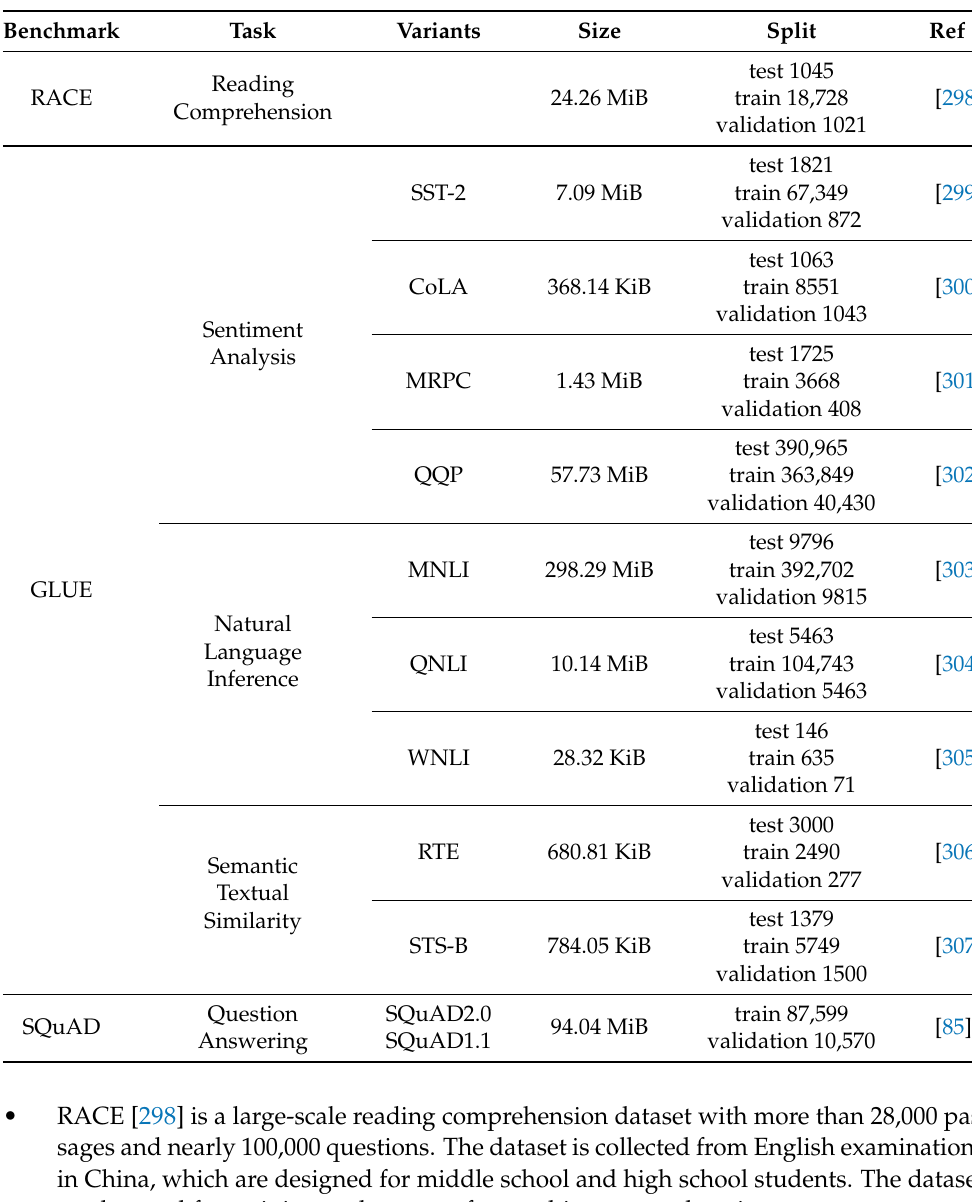
Table 3. NLP benchmarks list and